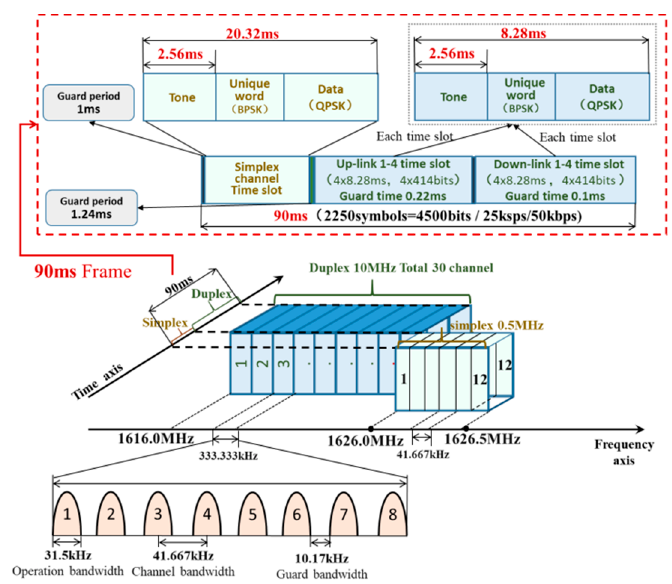
Figure 1. Iridium frequency allocation and frame structure.